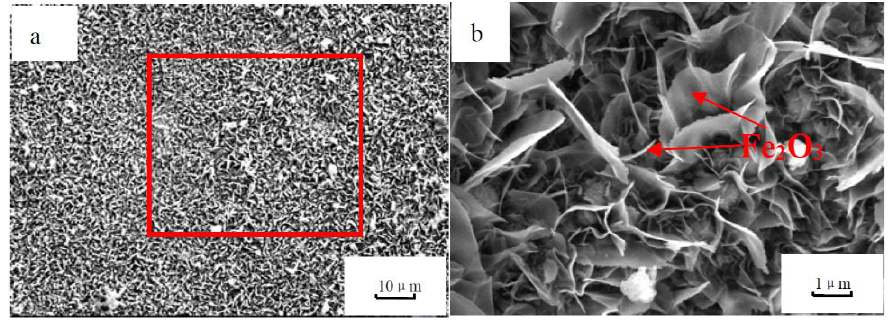
Figure 7. Surface morphology oxidized at 530 ◦ C for 500 h ( a ) 1000 × , ( b ) 5000 × .